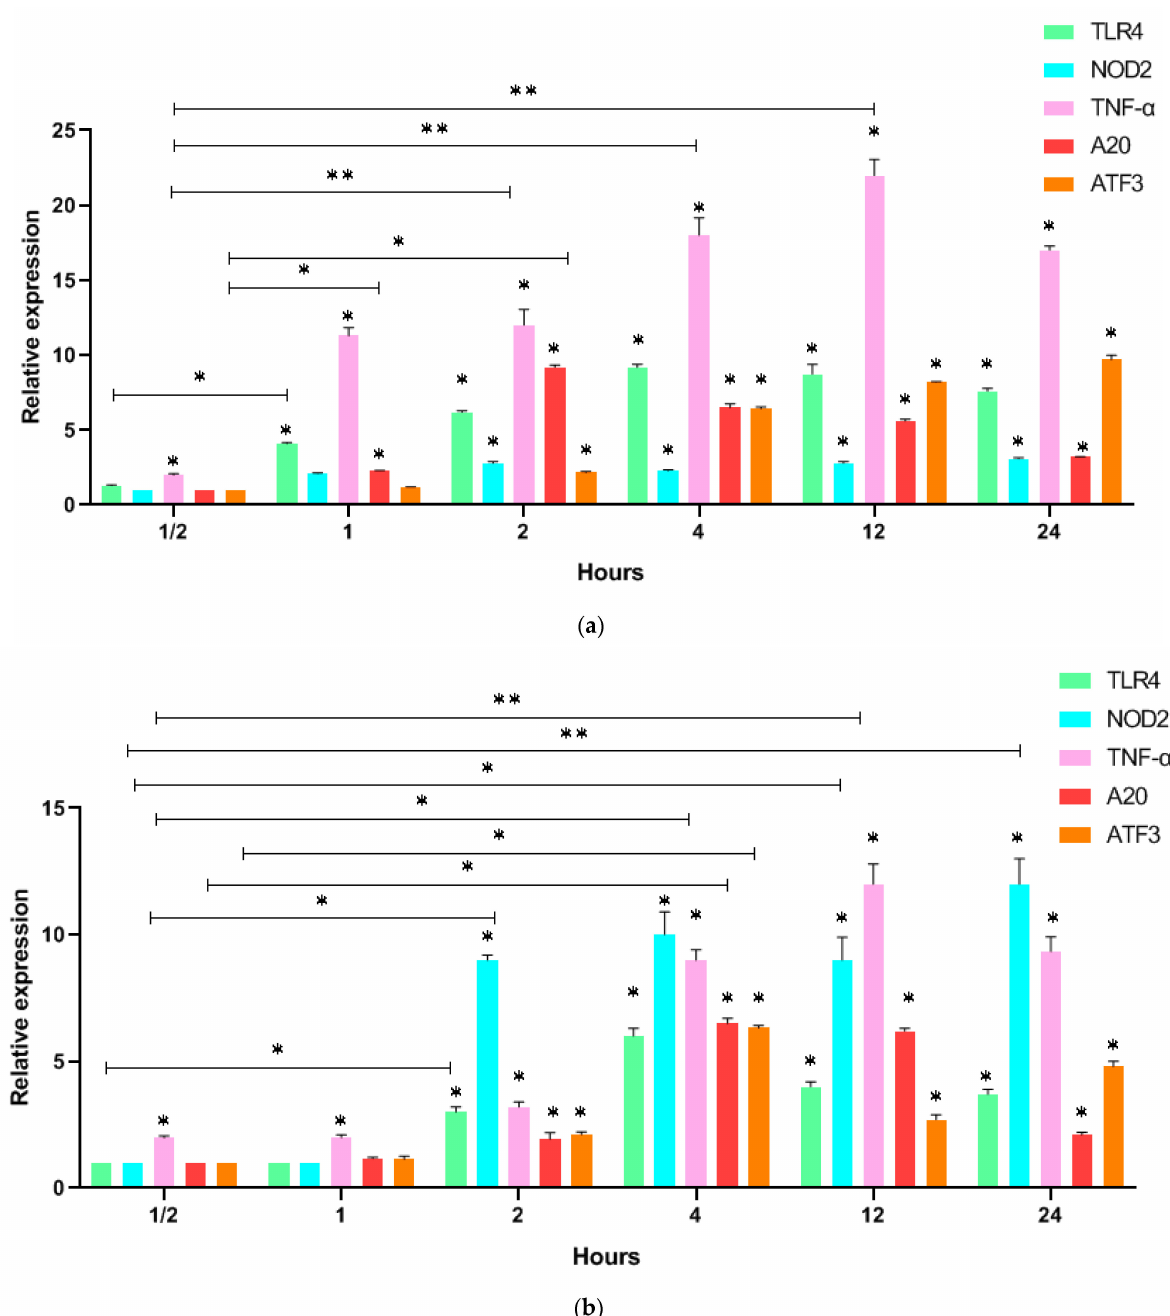
Figure 2. Relative expression of genes TLR4, NOD2, TNF- α , A20, and ATF3 with normalization for expression of GAPDH before in vitro stimulation in mononuclear cells of healthy donors after 30 min, 1, 2, 4, 12, and 24 h: ( a ) LPS; ( b ) GMDP; relative expression differences of more than 2 times were considered significant; data are represented as an average of three independent samples and error bars represent standard deviation; * p < 0.01; ** p <